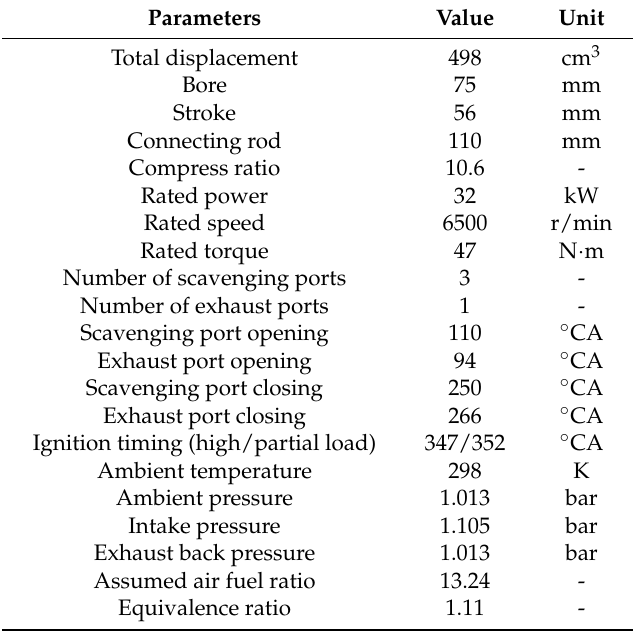
Figure 4. GT Power simulation model architecture. Table 1. Prototype engine specifications.